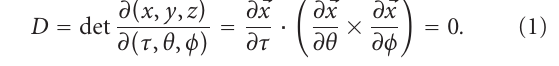
galaxies. Rises in the rotation curve of the Milky Way